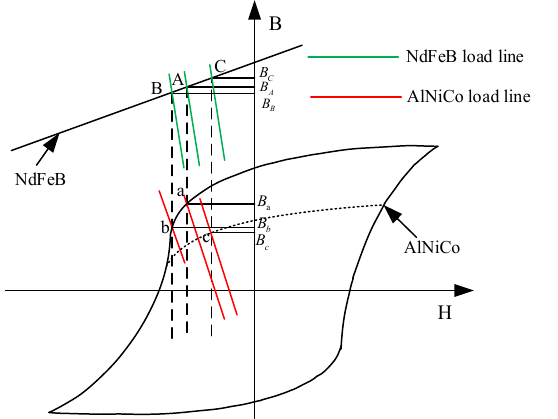
Figure 3. Illustration of flux-regulation mechanism of the parallel hybrid permanent magnet magnetic circuit.